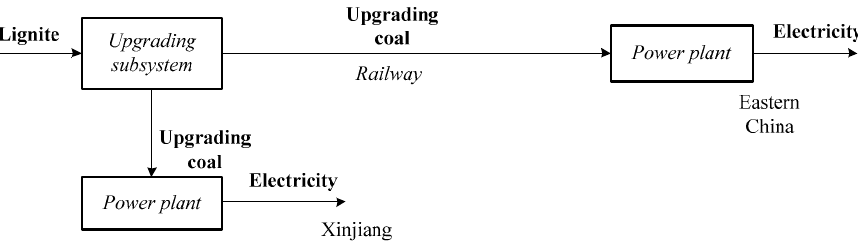
Figure 2. Conventional upgrading, power generation, and coal transport system.